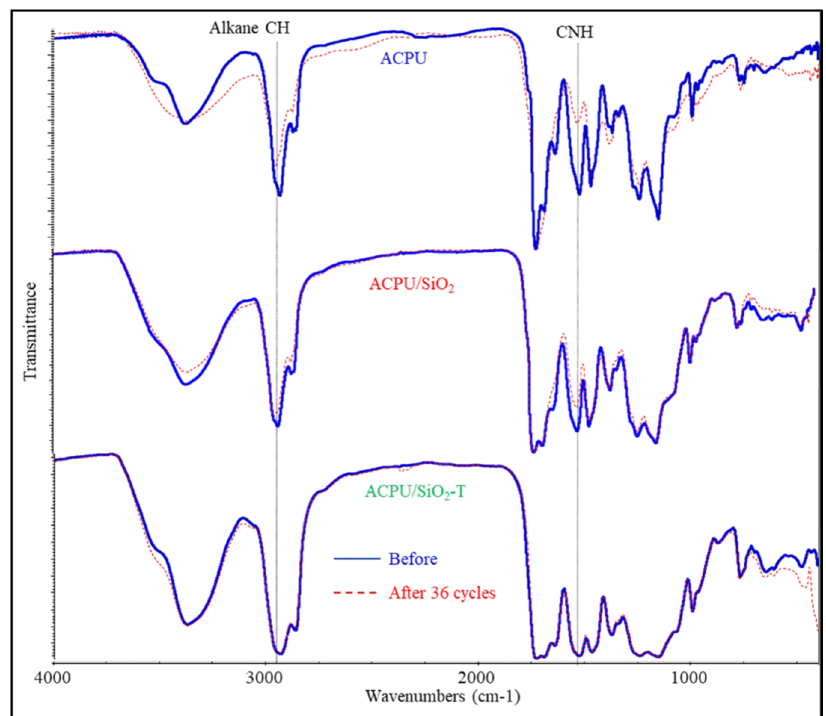
Figure 4. Infrared (IR) spectra of neat coating (ACPU), nanocomposite coating containing 2 wt % nano-SiO 2 (ACPU/SiO 2 ), and nanocomposite coating containing 2 wt % nano-SiO 2 , 2 wt % T 384, and 1 wt % T 292 (ACPU / SiO 2 -T), before and after 36 aging cycles.